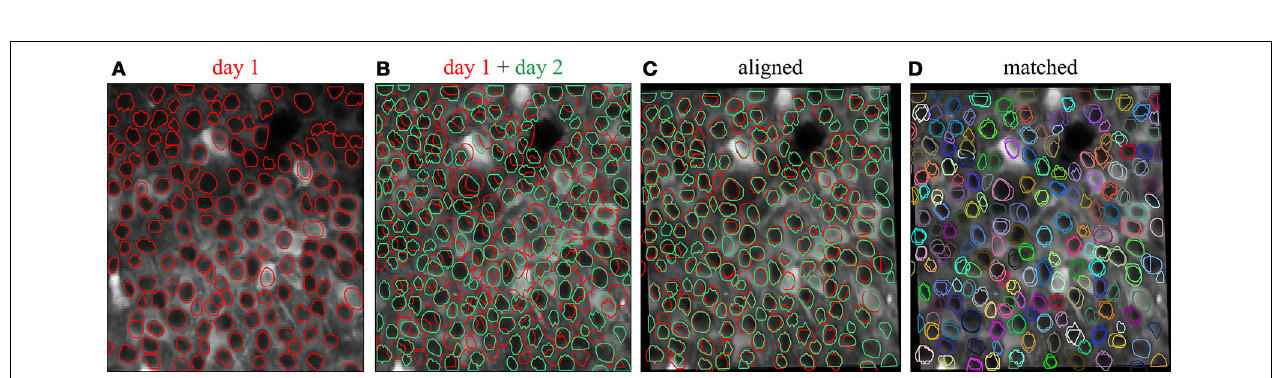
FIGURE 4 | Registration of ROIs across imaging sessions acquired on two different days. (A) ROIs (red) and time-averaged image for the first imaging session. (B) ROIs (green) and time-averaged image for the second imaging session, with ROIs for the first imaging session (red) shown for